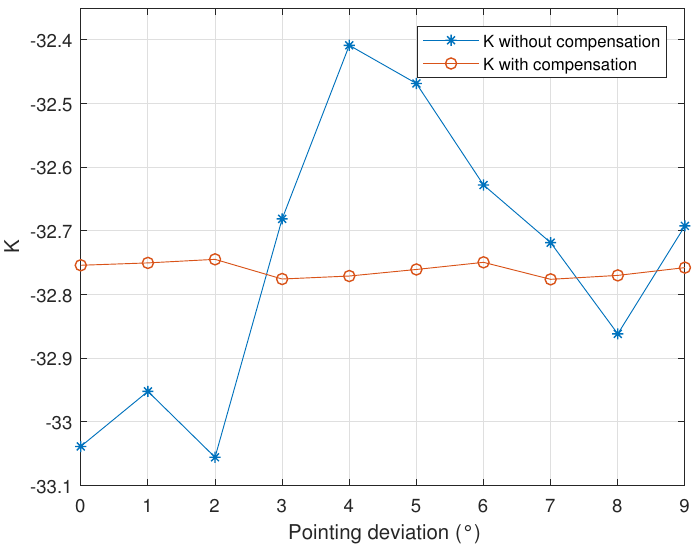
Figure 11. The comparison between K and K c